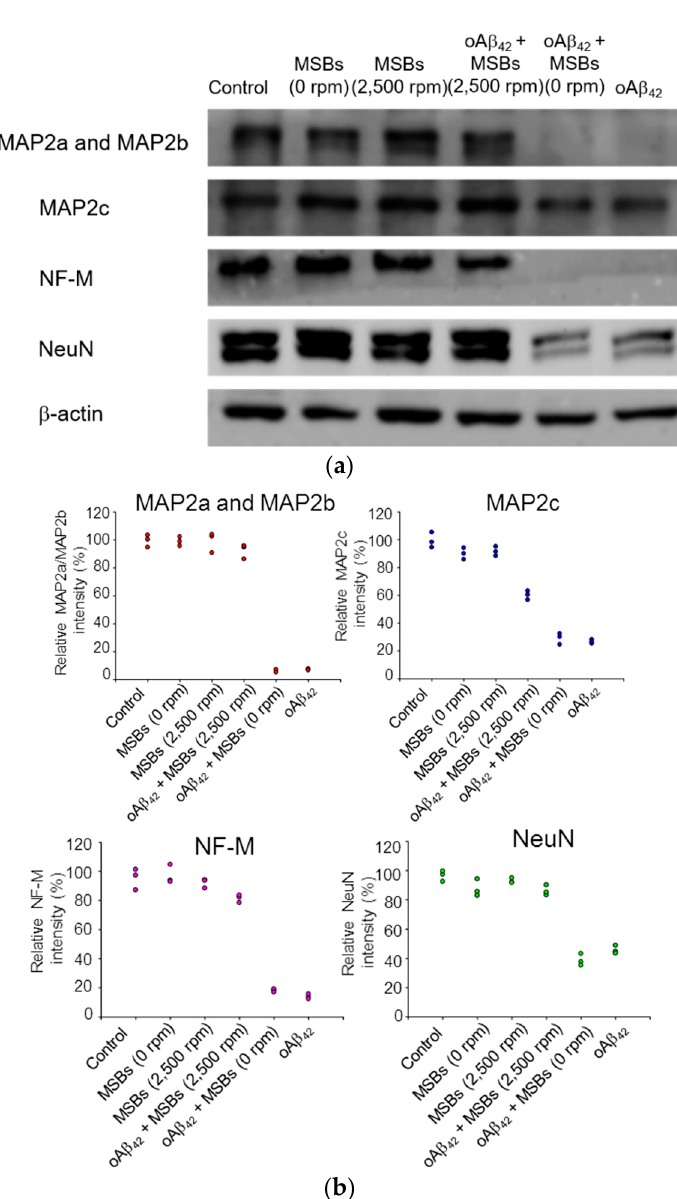
Figure 6. Neuron-specific protein expression of N2a cells receiving the magnetic stirring treatment. ( a ) Effects of oA β 42 on protein expression (MAP2a/MAP2b, MAP2c, NF-M, and NeuN) with and without the magnetic stirring ( n = 3). β -actin was used as the loading control. The oA β 42 concentration was 160 µ M. ( b ) The relative intensities of neuron-specific protein expression of N2a cells receiving magnetic stirring with MSBs were included.